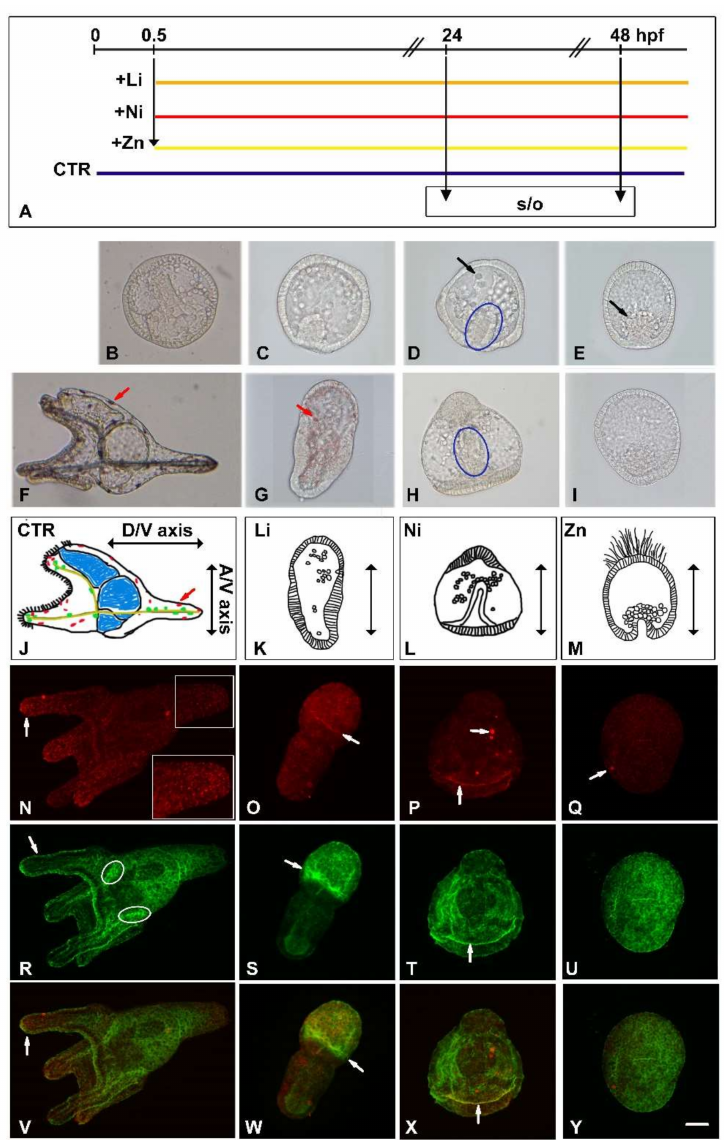
Figure 1. Morphologies of P. lividus embryos treated with Li, Ni, and Zn. ( A ) Schematic drawing of Li, Ni and Zn treatment experiments. Black line, hpf, in the upper part; the first vertical arrow indicates addition of 30 mM LiCl (Li), 0.5mM NiCl 2 (Ni), 0.1mM ZnSO 4 (Zn) at 0.5 hpf. Periods of treatment with Li, orange line; Ni, red line; Zn, yellow line. Untreated embryos (CTR), blue line. s/o indicates sampling (s) for NanoString nCounter gene expression assay and qPCR analyses and (o) microscopic observation. Embryos were observed at 24 ( B – E ) and 48 ( F – I ) hours post-fertilization (hpf). Untreated embryos: ( B ) control gastrula; ( F ) control pluteus. ( C , G ) Li-embryos; ( D , H ) Ni- embryos; ( E , I ) Zn-embryos. Blue ellipses in ( D , H ) indicate short archenteron. Black arrows in ( D , E ) indicate cells grouped inside the blastocoelic cavity. Red arrows in ( F , G ) indicate pigment cells. Schemes of embryos at 48 hpf: control pluteus, CTR ( J ); Li-embryo, Li ( K ); Ni-embryo, Ni ( L ); Zn-embryo, Zn ( M ). Animal/Vegetal (A/V), Dorso/Ventral (D/V) axes are indicated in the scheme of pluteus embryo. ( N – Q ) Anti-Sox2 antibody (red); ( R – U ) Ab-295 (green); ( V – Y ) Merged images (yellow) of the relative Anti-Sox2 ( N – Q ) and Ab-295 ( R – U ) images, respectively. The image in the white frame in ( N ) indicates 1.4 × magnification of the pluteus apex, where brightness and contrast have been increased. White arrows in ( N – Q ) indicate Sox2-positive cells. White ellipses in ( R ) indicate small central ganglionic structures. White arrows in ( R – T ) and ( V – X ) indicate ciliary band. Bar 20 µ m for ( B – I ) and ( N – Y